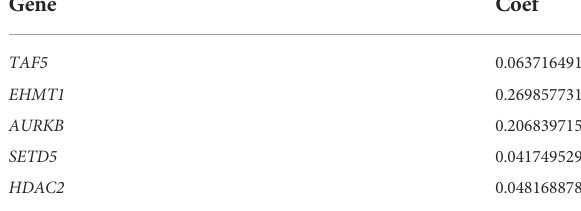
TABLE 1 Correlation coeffcients of fi ve selected DECRs. Gene